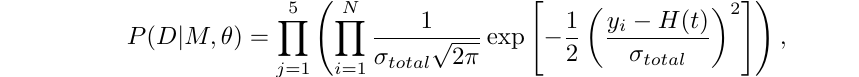
Fig. 2.— The CS100 data points (in black) with the fits calculated for sinusoidal modulation H 365.25 days, and background-only model H 0 ( t ) (Eq. 2, in blue). As we can see, by eye it is hard to distinguish between the two models. The data was obtained from the COSINE-100 collaboration (private